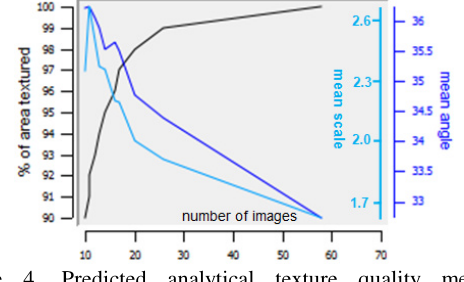
Figure 4. Predicted analytical texture quality measures depending on the number of selected